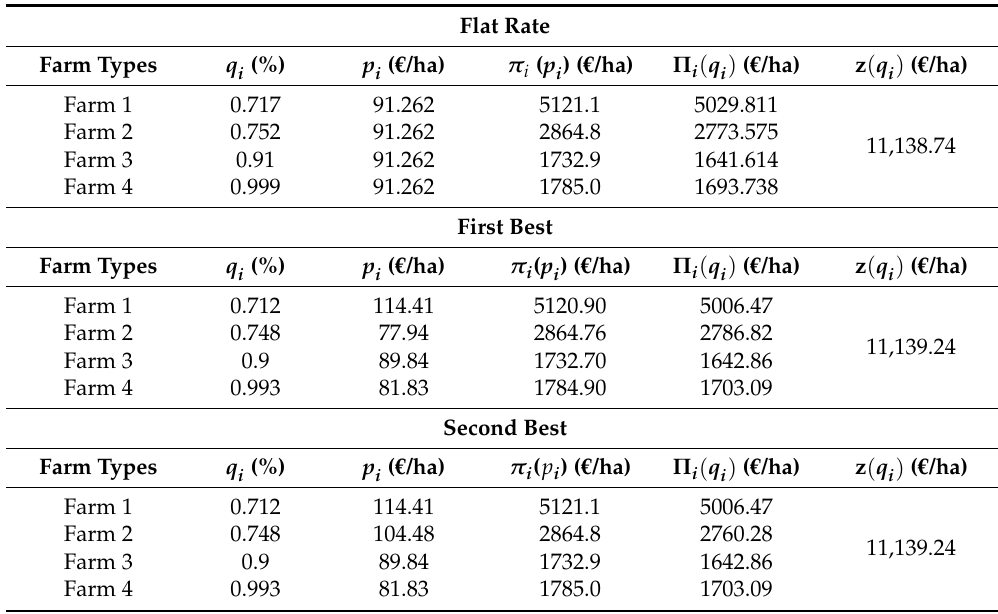
Table 3. Flat rate, first best, and second best water payment